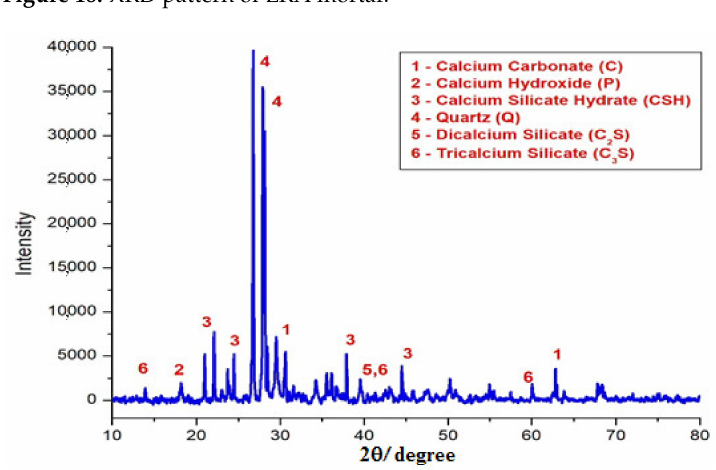
Figure 18. XRD pattern of LRA mortar.